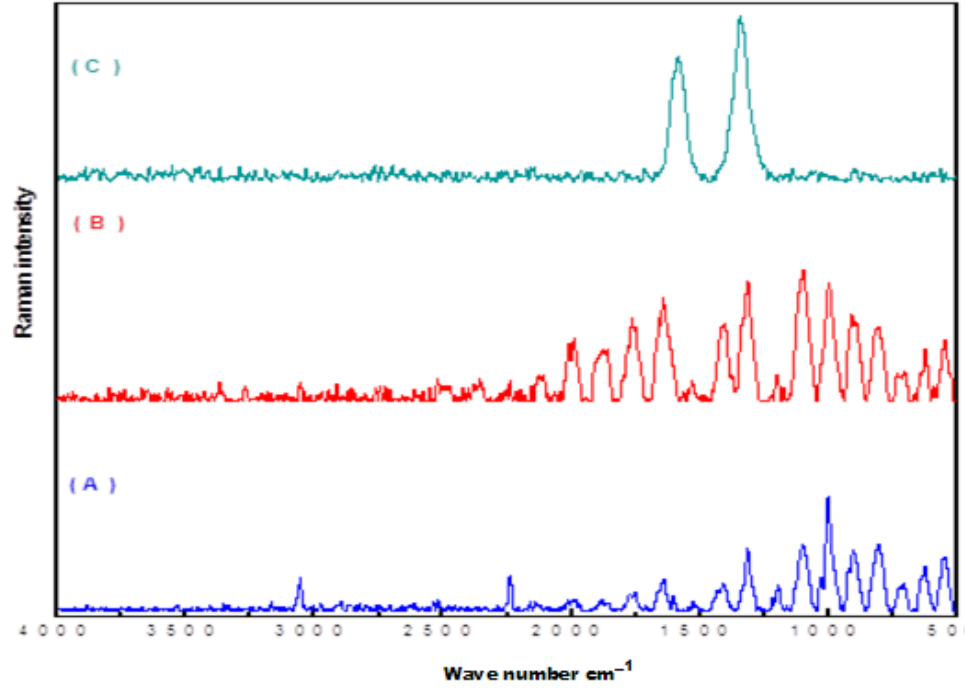
Figure 4. Raman spectrum of ( A ) P(AN- co -St), ( B ) SP(AN- co -St), and ( C ) P(AN- co -St)/MWCNTs. Table 3. Raman spectra showing functional group vibration for different nanocomposites after the adsorption of